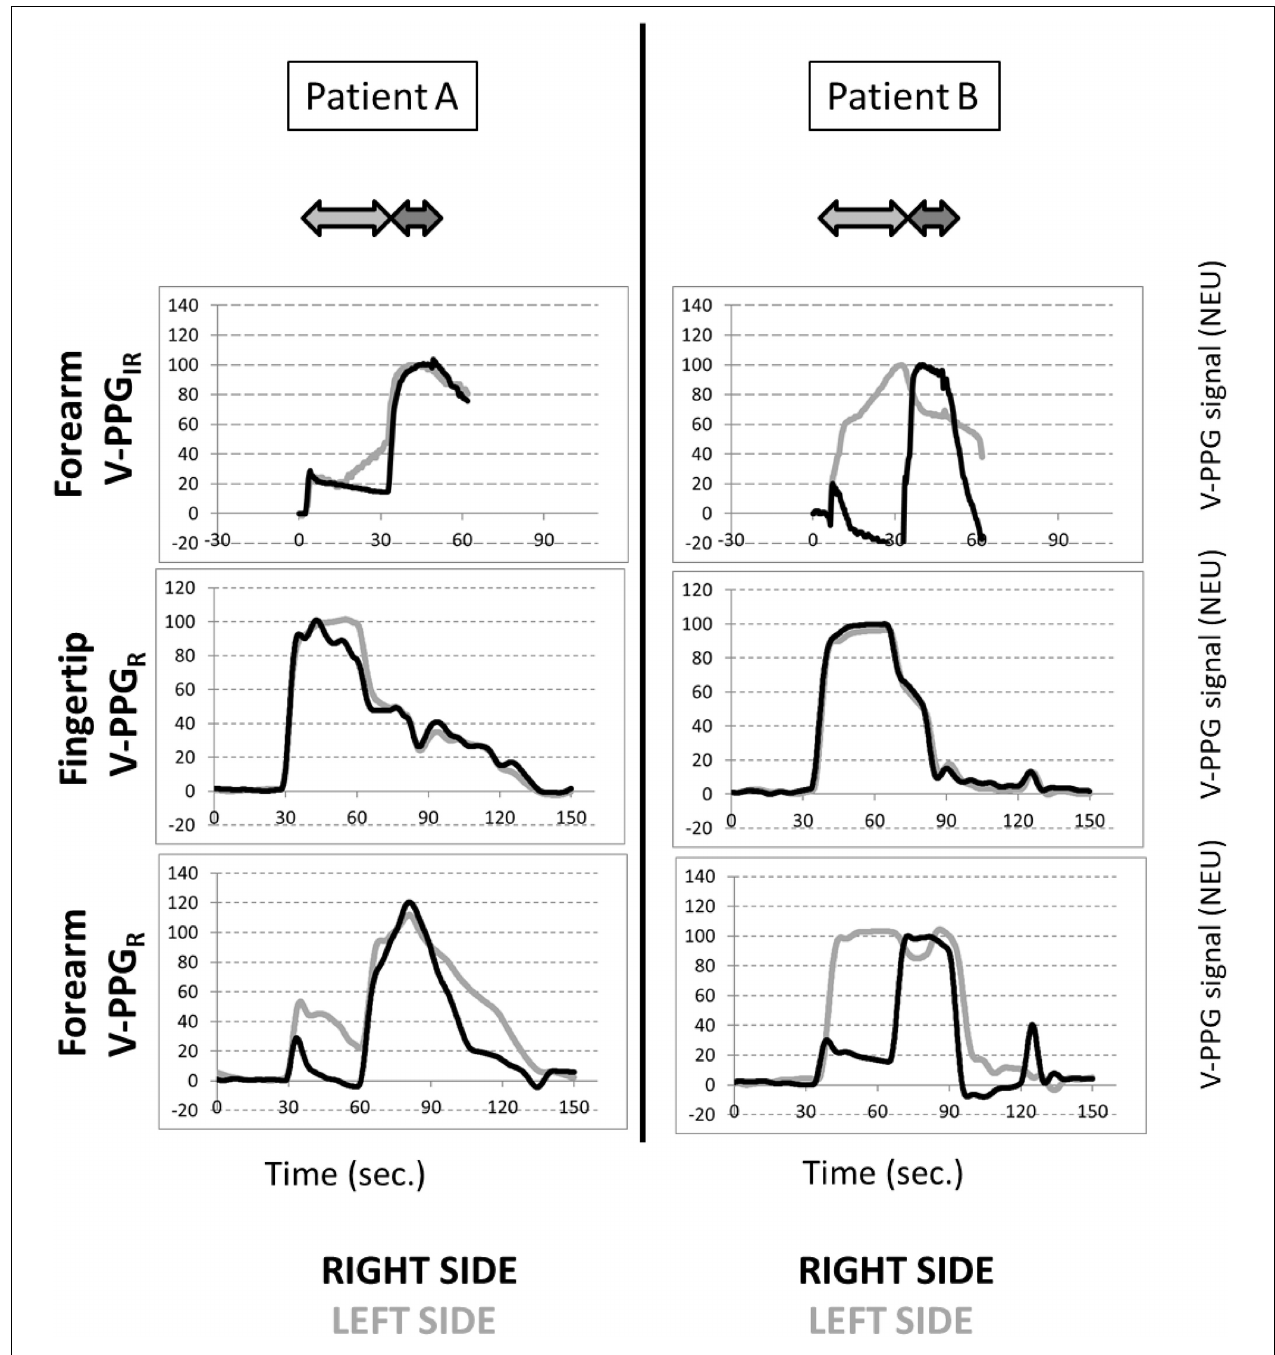
FIGURE 3 | Example of recordings in a patient with bilateral symptoms (patient A) and unilateral left symptoms (patient B) during the candlestick (light gray arrow) and prayer (dark gray arrow) maneuvers. Zero is resting state with filled veins, and 100% is the maximal volume observed until the end of the prayer maneuver. Since a small overshoot was sometimes observed when moving the arms down after the prayer maneuver, some values may be in excess of 100%. It is noted that the system used for VPP IR does not allow recordings in excess of 60